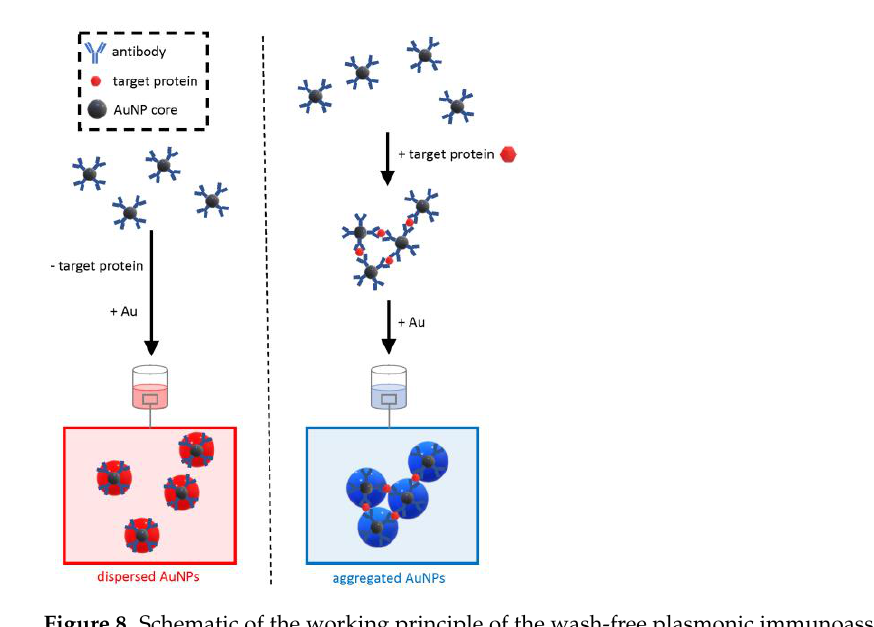
Figure 8. Schematic of the working principle of the wash-free plasmonic immunoassay. The method relies on the growth of antibody-conjugated core AuNPs as a dispersed colloidal suspension (negative sample) or aggregated clusters (positive samples).